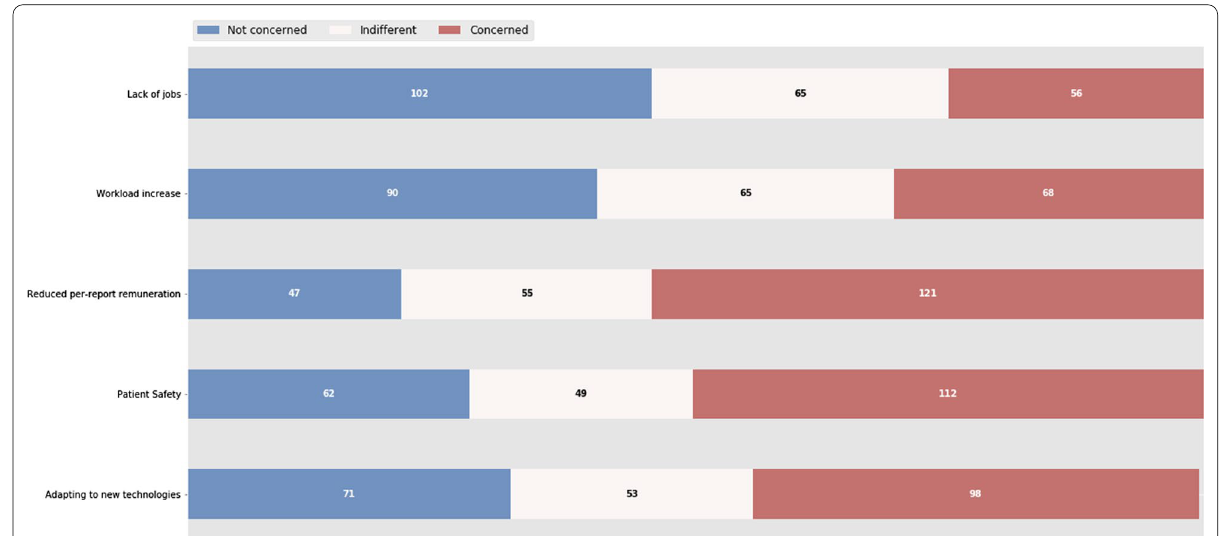
Fig. 4 Concerns about the adoption of AI in radiology, as perceived by the respondents. The x ‑axis shows the number of